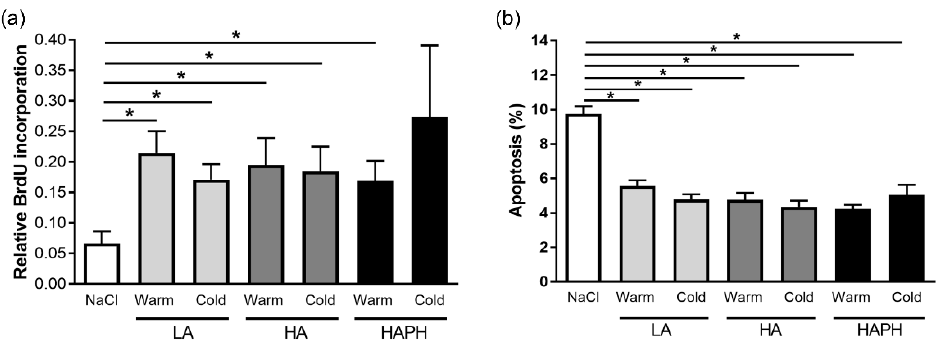
Figure 4. Effects of isolated microparticles (MPs) on proliferation and apoptosis of human pulmonary artery smooth muscle cells (PASMCs). Human PASMCs are exposed to isolated MPs and their effects on proliferation ( a ) and apoptosis ( b ) are shown. LA — lowlanders, HA — highlanders, HAPH — highlanders with pulmonary hypertension. Results are presented as mean ± SEM (n = 5 – 7). * p < 0.05 values are considered statistically significant.